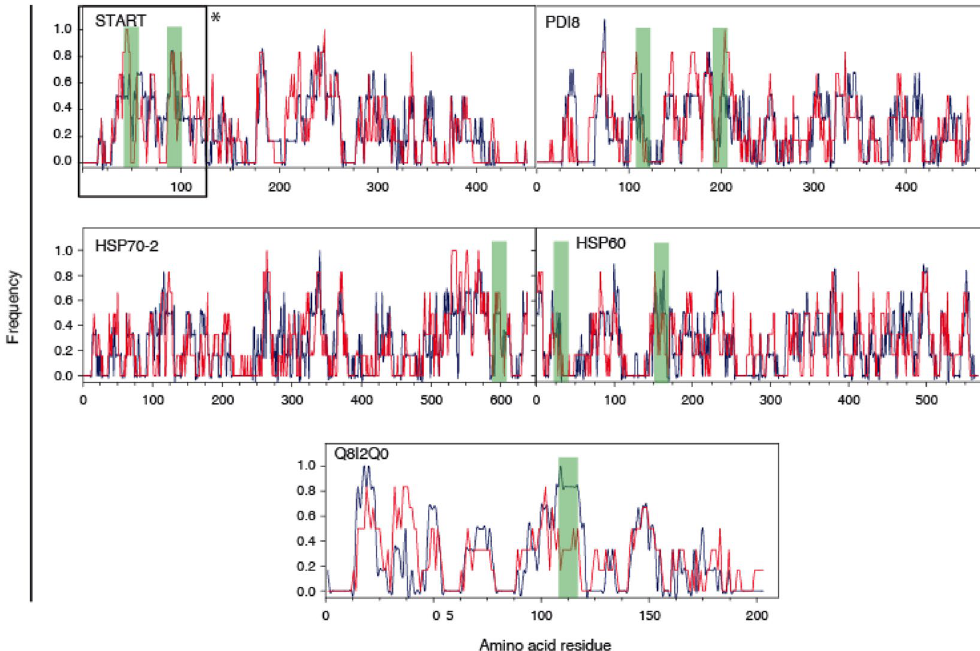
Figure 2. Comparison of IgG reactivity frequency between serum from adult patients with (blue: ASC) and without (red: ANP) parasitemia from Breman-Asikuma. X-axis shows amino acid sequence length of each antigen. Y-axis shows fluorescence signals above a cutoff stablished as the third quartile of the recorded data. Data from high IgG sera are shown. The positions of the selected 20-mer peptides are shown as overlay green bars.